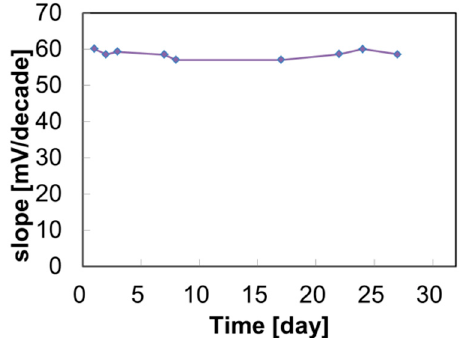
Figure 4. Long-term stability of P7281-PU-based ISFETs. This measurement is done in only KNO 3 solution.